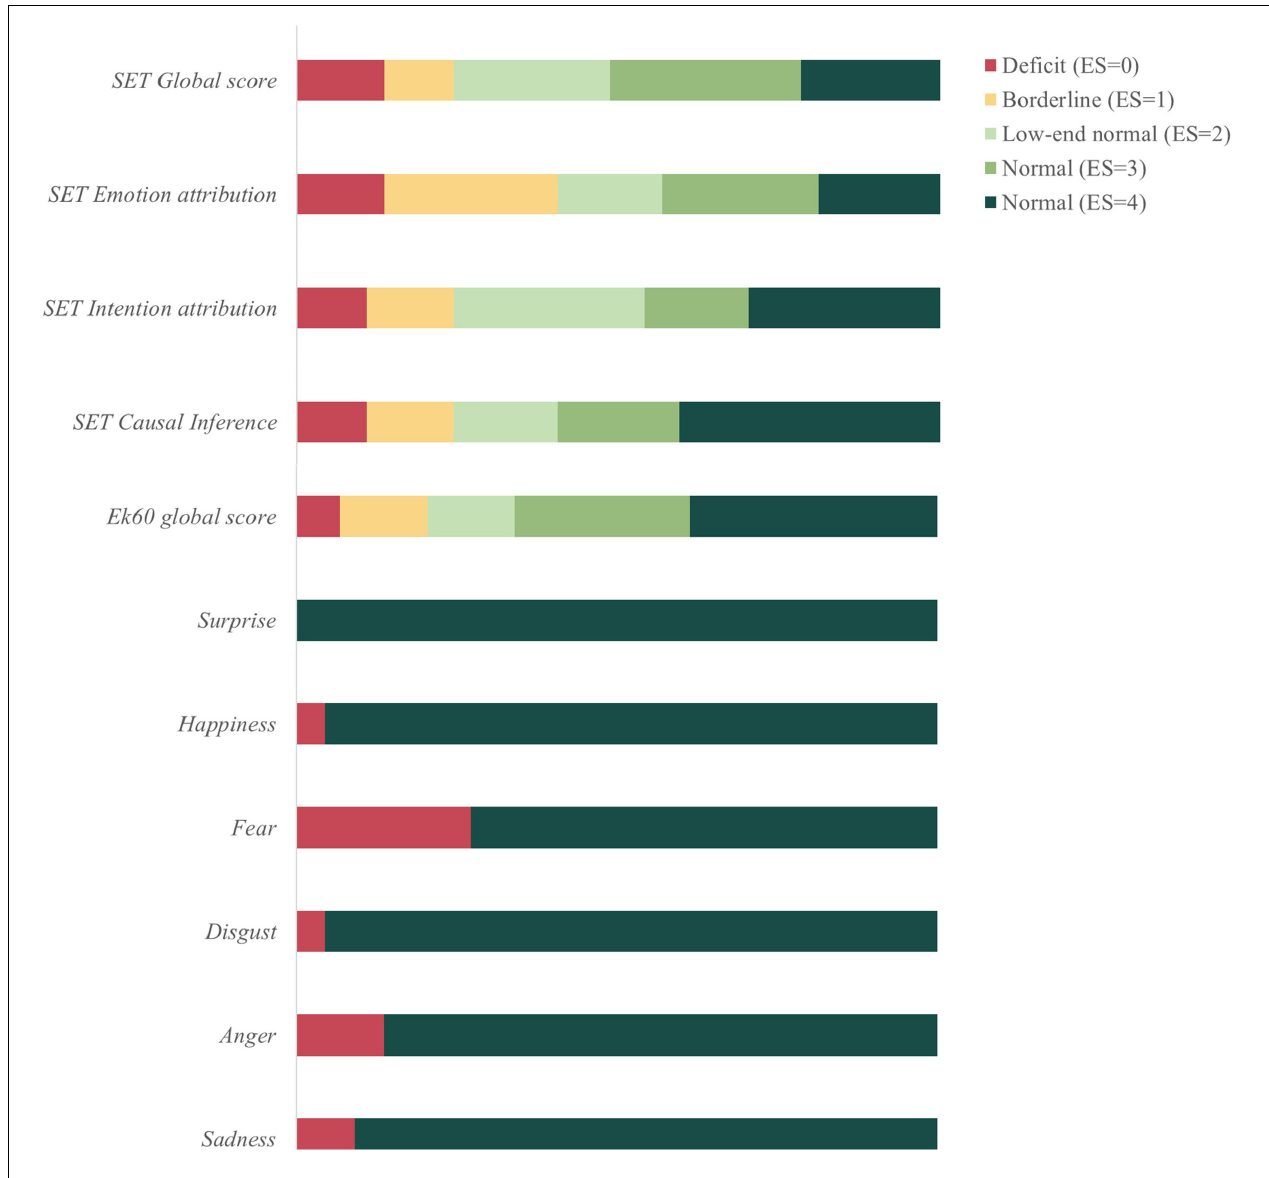
FIGURE 1 | Socio-cognitive dysfunctions in Parkinson’s disease (PD) patients compared to healthy controls (HC). SET, story-based empathy task; Ek60, Ekman 60-faces test; ES, equivalent scores according to Capitani and Laiacona (1997)